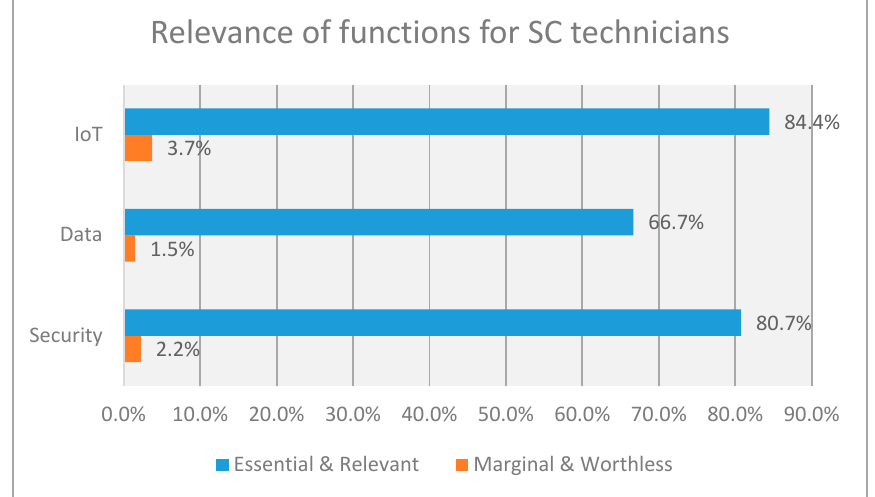
Figure 3. Summary of relevance of functions for SC technicians.